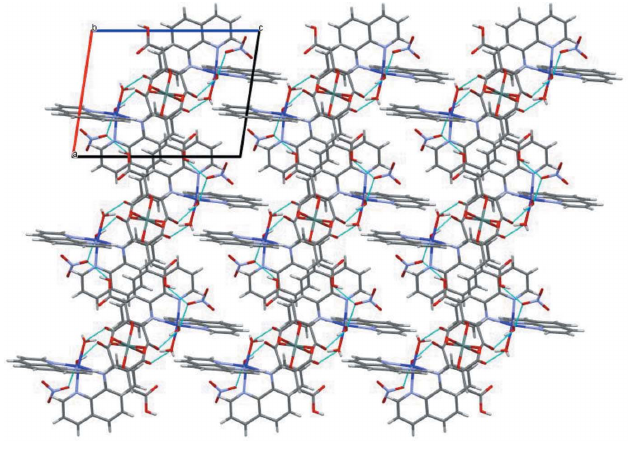
Figure 2 The crystal packing of [Co(H 2 O) 2 (phen) 2 ] 2 [Ge(HCit) 2 (NO 3 ) 2 ] viewed along the b